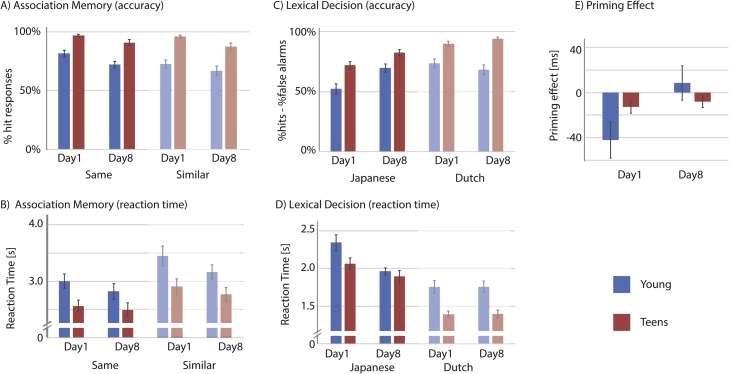
Behavioral results.Error bars denote standard error of the means.